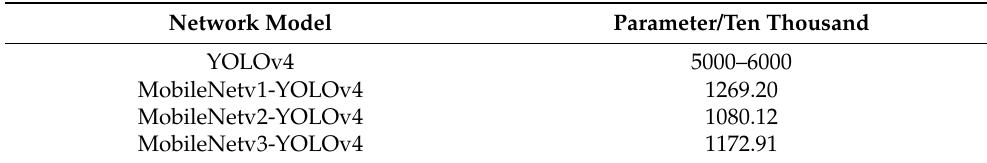
Table 2. Parameter statistics of four network